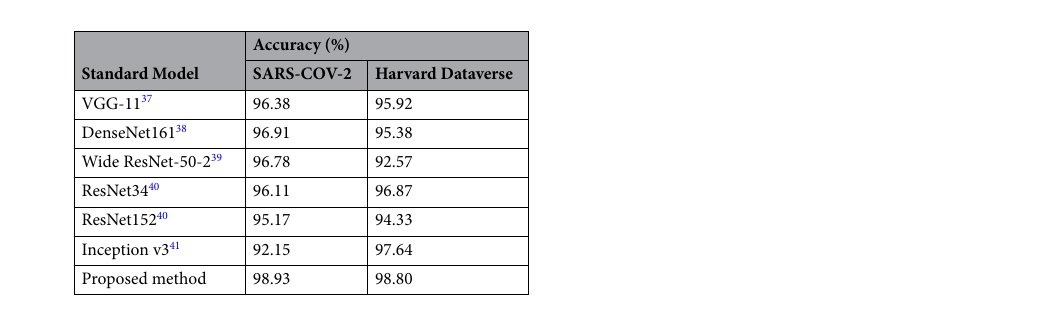
Table 5. Comparison of the proposed framework with some standard CNN